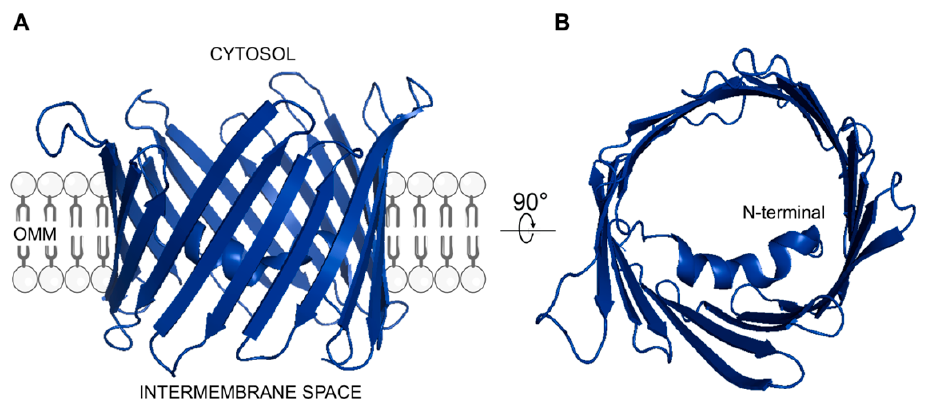
Figure 1. 3D structure of human VDAC1 ( A ) Lateral view showing the β -barrel organization. The protein is embedded in the OMM facing hydrophilic residues towards cytosolic or mitochondrial IMS compartment. ( B ) Top view showing the α -helix structured N-terminal domain located within the channel lumen. Both structures were drawn by using PyMOL software (Molecular Graphics System, version 2.4.1, 2021) and the available PDB structure (ID: 2JK4) as template.